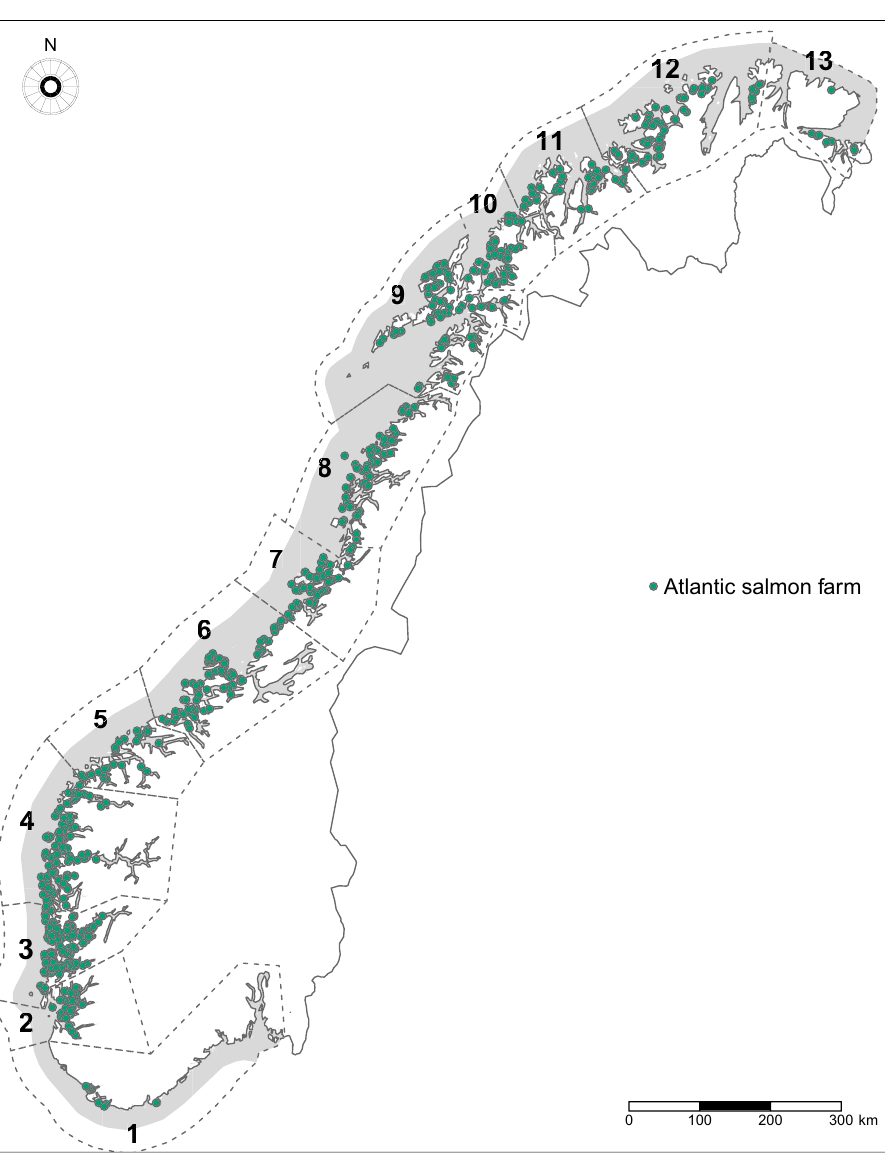
18 months of life at sea. Longer periods of life at sea are possible depending on fish growth rates and the farmers’ management preferences. When all cages on a farm are emptied, a minimum fallowing period of 2 months is obligatory in Norway before stocking a new fish cohort in the farm. Our target population was Atlantic salmon ( Salmo salar L.) from commercial farms in Norway, farmed for the purpose of food production. Figure 6 shows registered farms (n = 717) in the national database during the period of this study, between January 2014 and December 2019. During this period, the number of active farms per month ranged from 271 to 421. These farms are distributed across 13 distinct production zones along all the Norwegian coast, established by regulations 65 . Common characteristics of farms located within a zone includes their water current connectivity and geographical location. The zones have been used for management decisions, for example, strategies towards minimizing the spread of sea lice 75–77 . The density of farms in each of the zones varies considerably. We conducted a retrospective study using farm-level data. We used the count of dead fish for statistical inferences and predictions. Based on existing literature and discussions among the authors, we hypothesized determinants and their putative association with salmon mortality and summarized this in a directed acyclic graph (DAG) (Fig. 7).